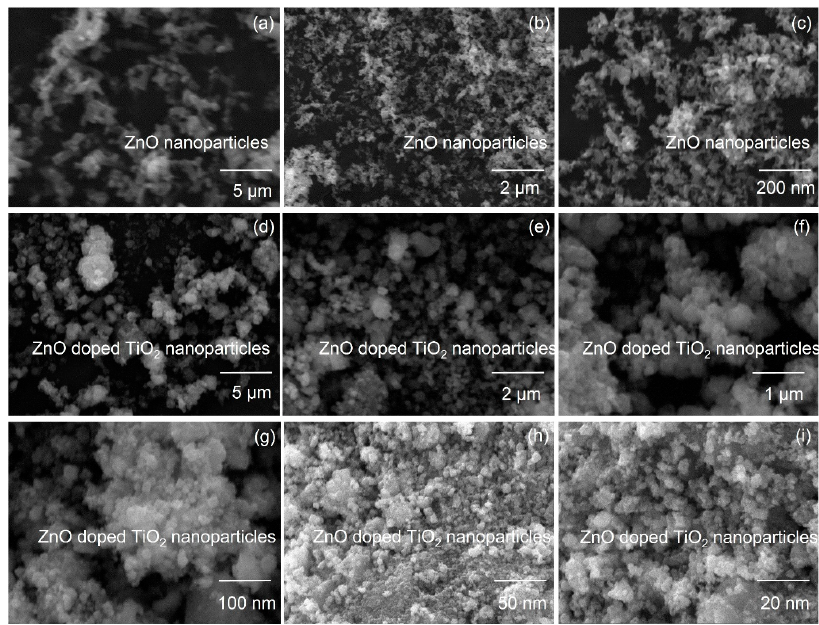
Catalysts 2023 , 13 , x FOR PEER REVIEW Figure 2. ( a – i ) SEM of pure ZnO and ZnO doped TiO 2 nanocomposites. Figure 2. ( a – i ) SEM of pure ZnO and ZnO doped TiO 2 nanocomposites.